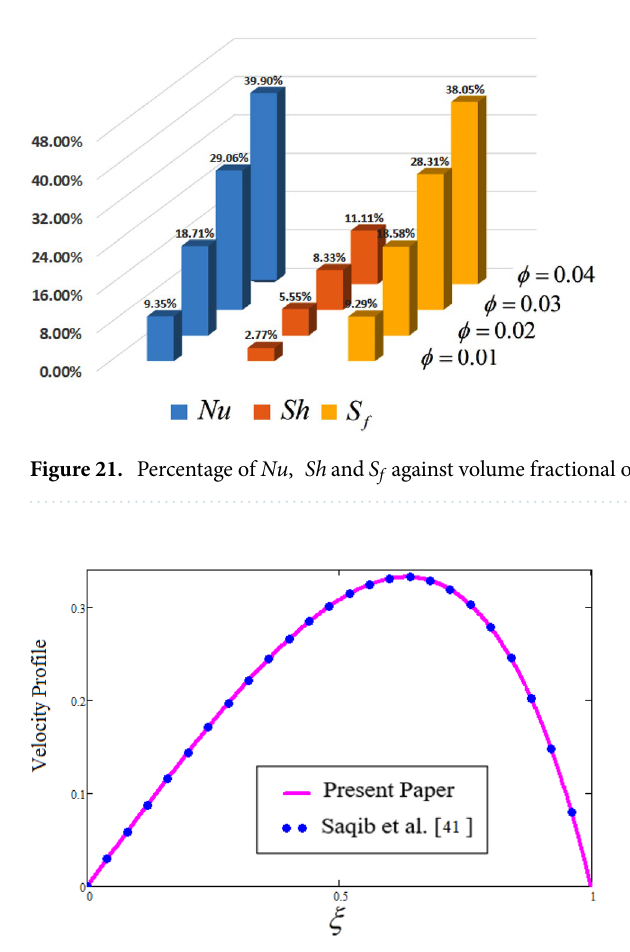
Figure 22. Comparison study with Saqib et al . 41 .